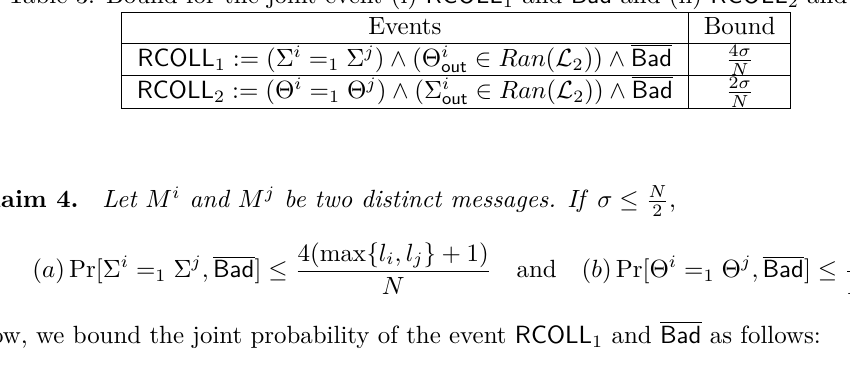
Table 3: Bound for the joint event (i) RCOLL 1 and Bad and (ii) RCOLL 2 and Bad . Events